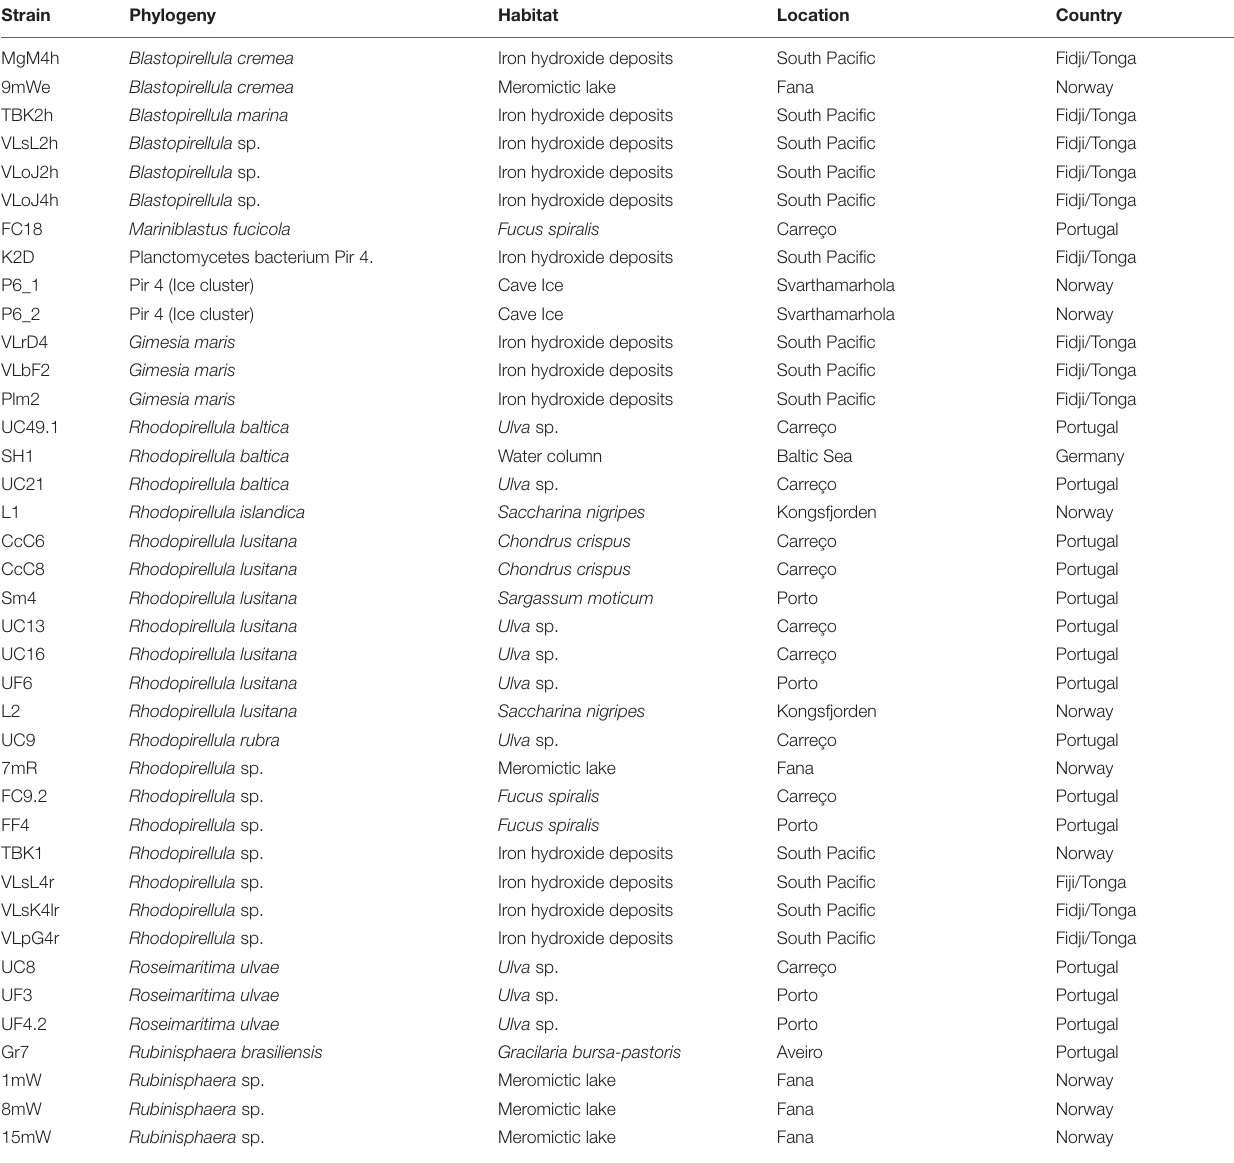
TABLE 1 | Phylogeny, habitat and location of Planctomycetes strains used in this